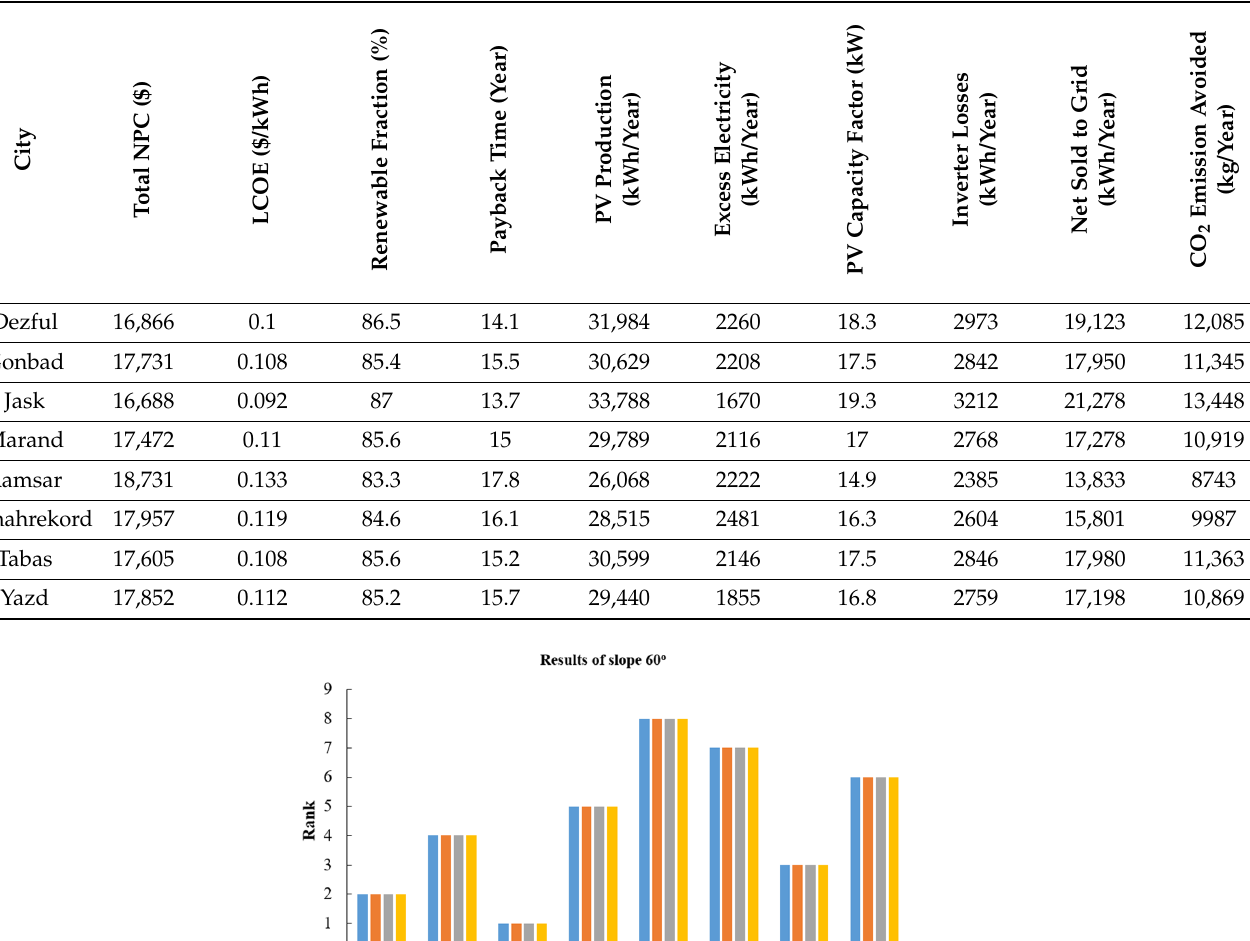
Table 14. Results of ranking of cities on a 60° slope.